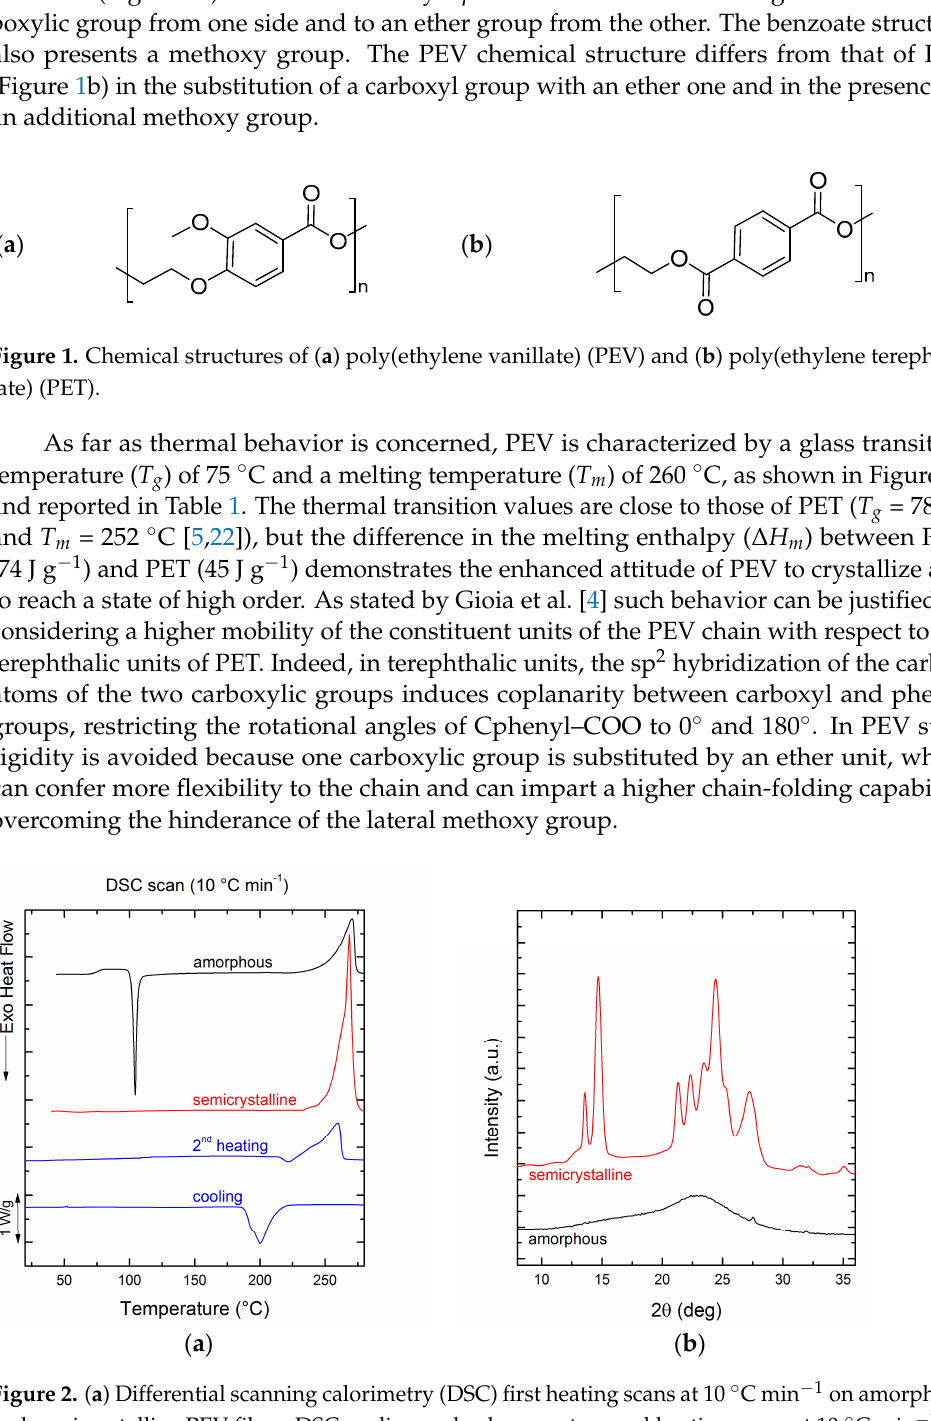
Figure 2. ( a ) Differential scanning calorimetry (DSC) first heating scans at 10 °C min − 1 on amorphous and semicrystalline PEV films. DSC cooling and subsequent second heating scans at 10 °C min − 1 on PEV after erasing the thermal history. ( b ) Wide angle X-ray scattering (WAXS) pattern on amorphous and semicrystalline PEV films.